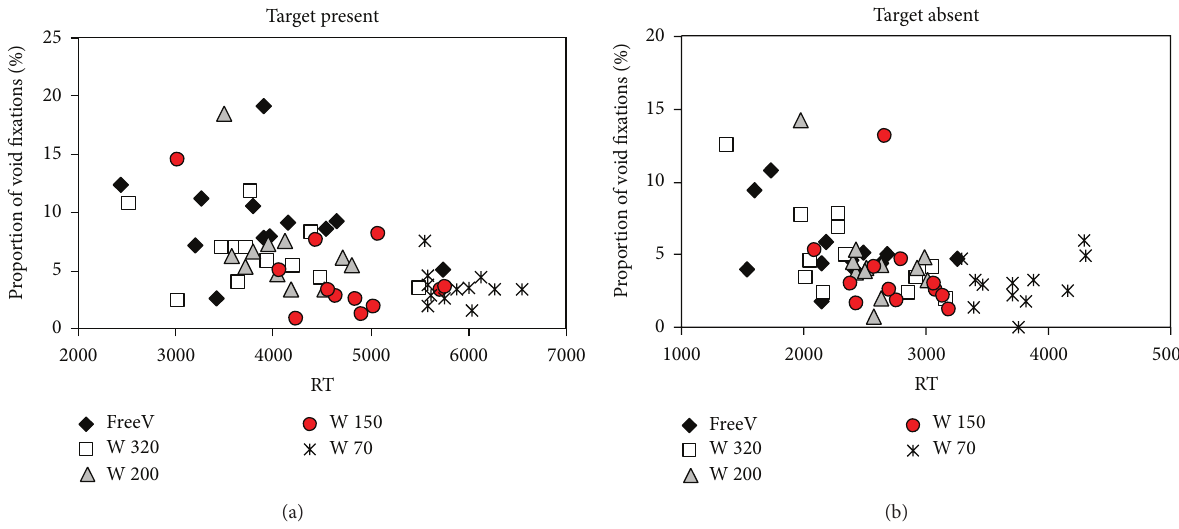
Figure 6: Effects of COG fixations on search performance (RT), Experiment 2. Mean individual search times as a function of the proportion of fixations into a void region, depicted separately for the free viewing condition (FreeV; black diamonds) and the 4 different restricted viewing conditions (W = window, with number specifying the size of the viewable area in pixels). As in Experiment 1, a higher proportion of void fixations is associated with shorter RT, both on target present trials (a) and target absent trials